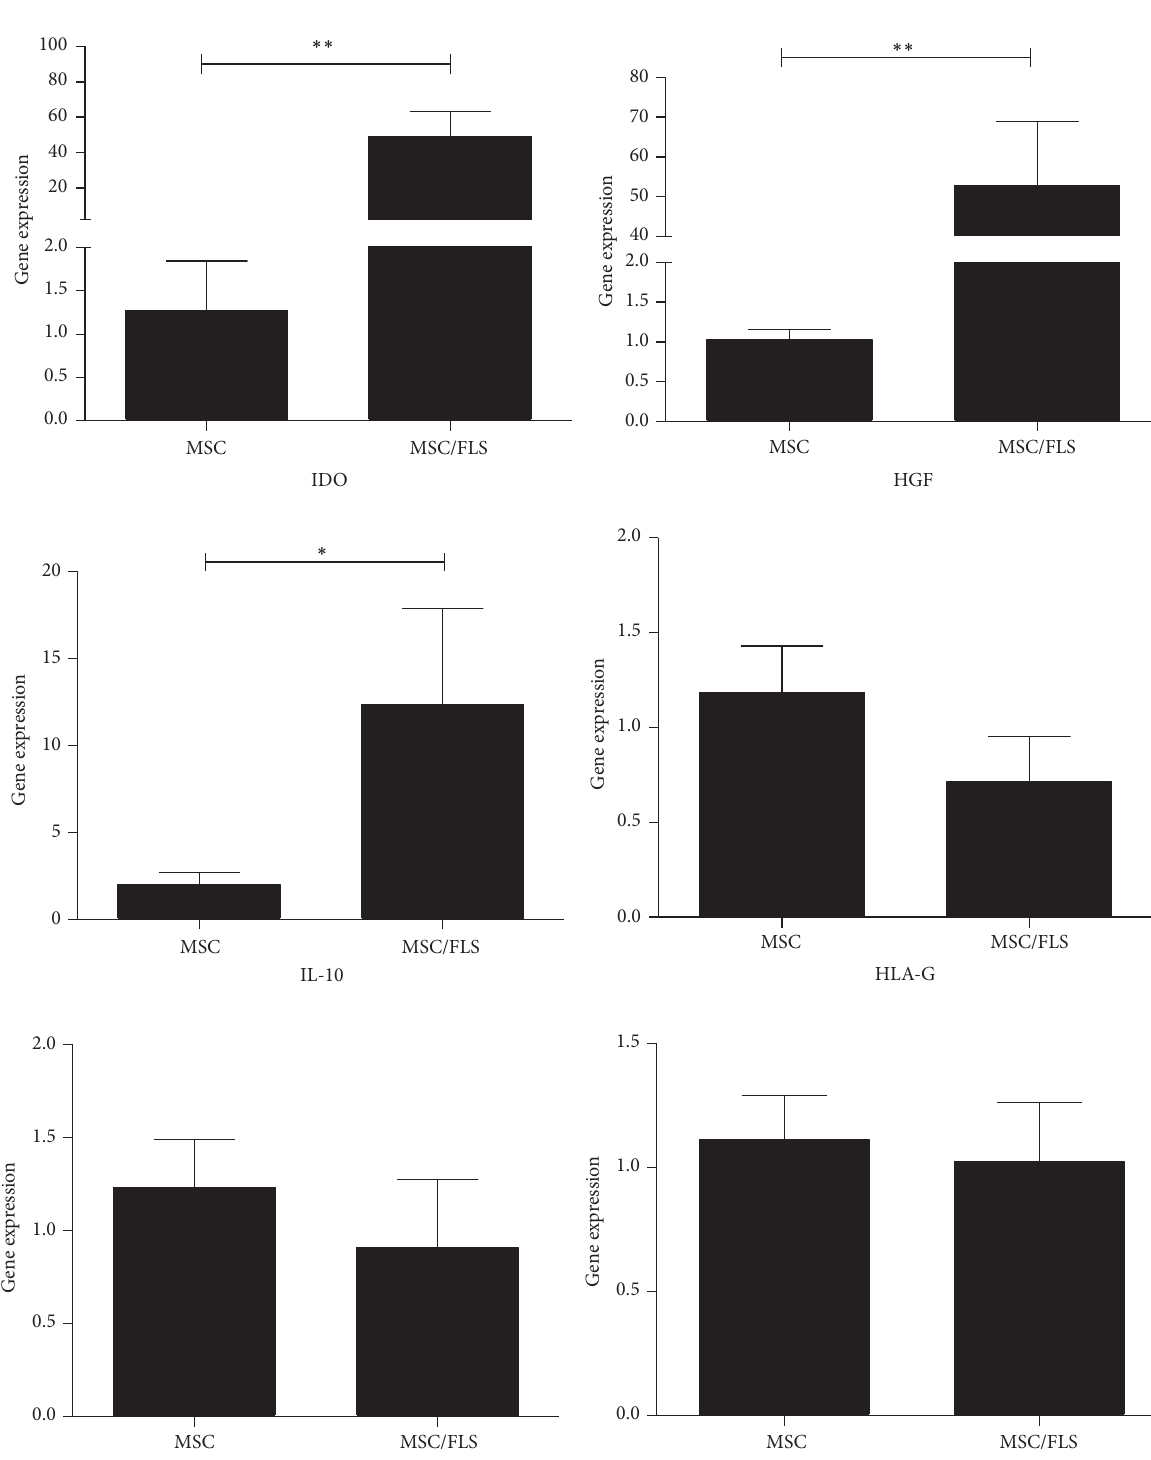
Figure 3: Soluble factors expressed by UCMSC. Expression of COX-2, HGF, HLA-G, IDO, TGF- 𝛽 , and IL-10 by UCMSC cocultured with FLS. MSC: mesenchymal stem cells; FLS: fibroblast-like synoviocytes. ∗ 𝑃 < 0.05 ; ∗∗ 𝑃 < 0.01